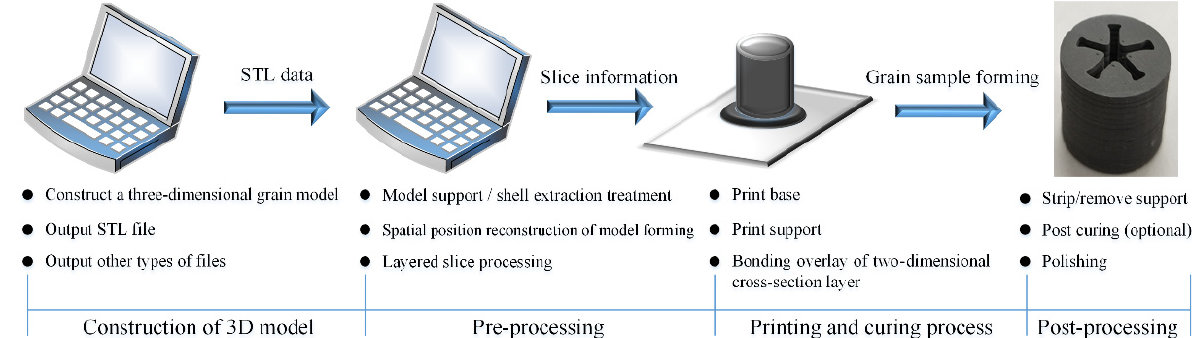
Figure 4. Schematic diagram of light-curing 3D printing technology. The light-curing 3D printing forming process of special-shaped energetic grains mainly includes four processes: construction of the three-dimensional model, pre-pro- cessing, the printing and curing process, and post-processing, as shown in Figure 5.